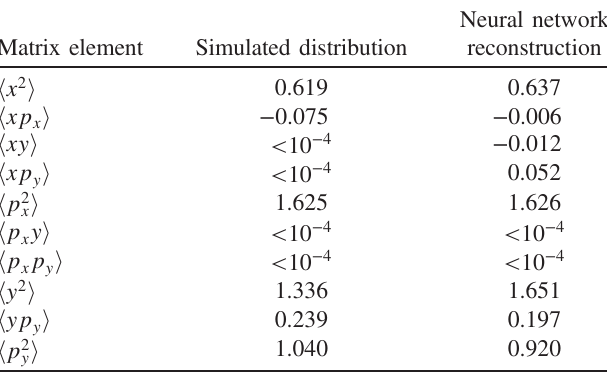
TABLE III. Covariance matrix elements in the simple Gaussian test distribution shown in Fig. 10. The values are obtained from 1D Gaussian fits to projections from the 4D phase space onto the appropriate axes and are given in arbitrary units. Values from the original simulated distribution are compared with the reconstruction from the neural network with simulated quadru- pole scan results (first and third rows in Fig. 10, respectively).